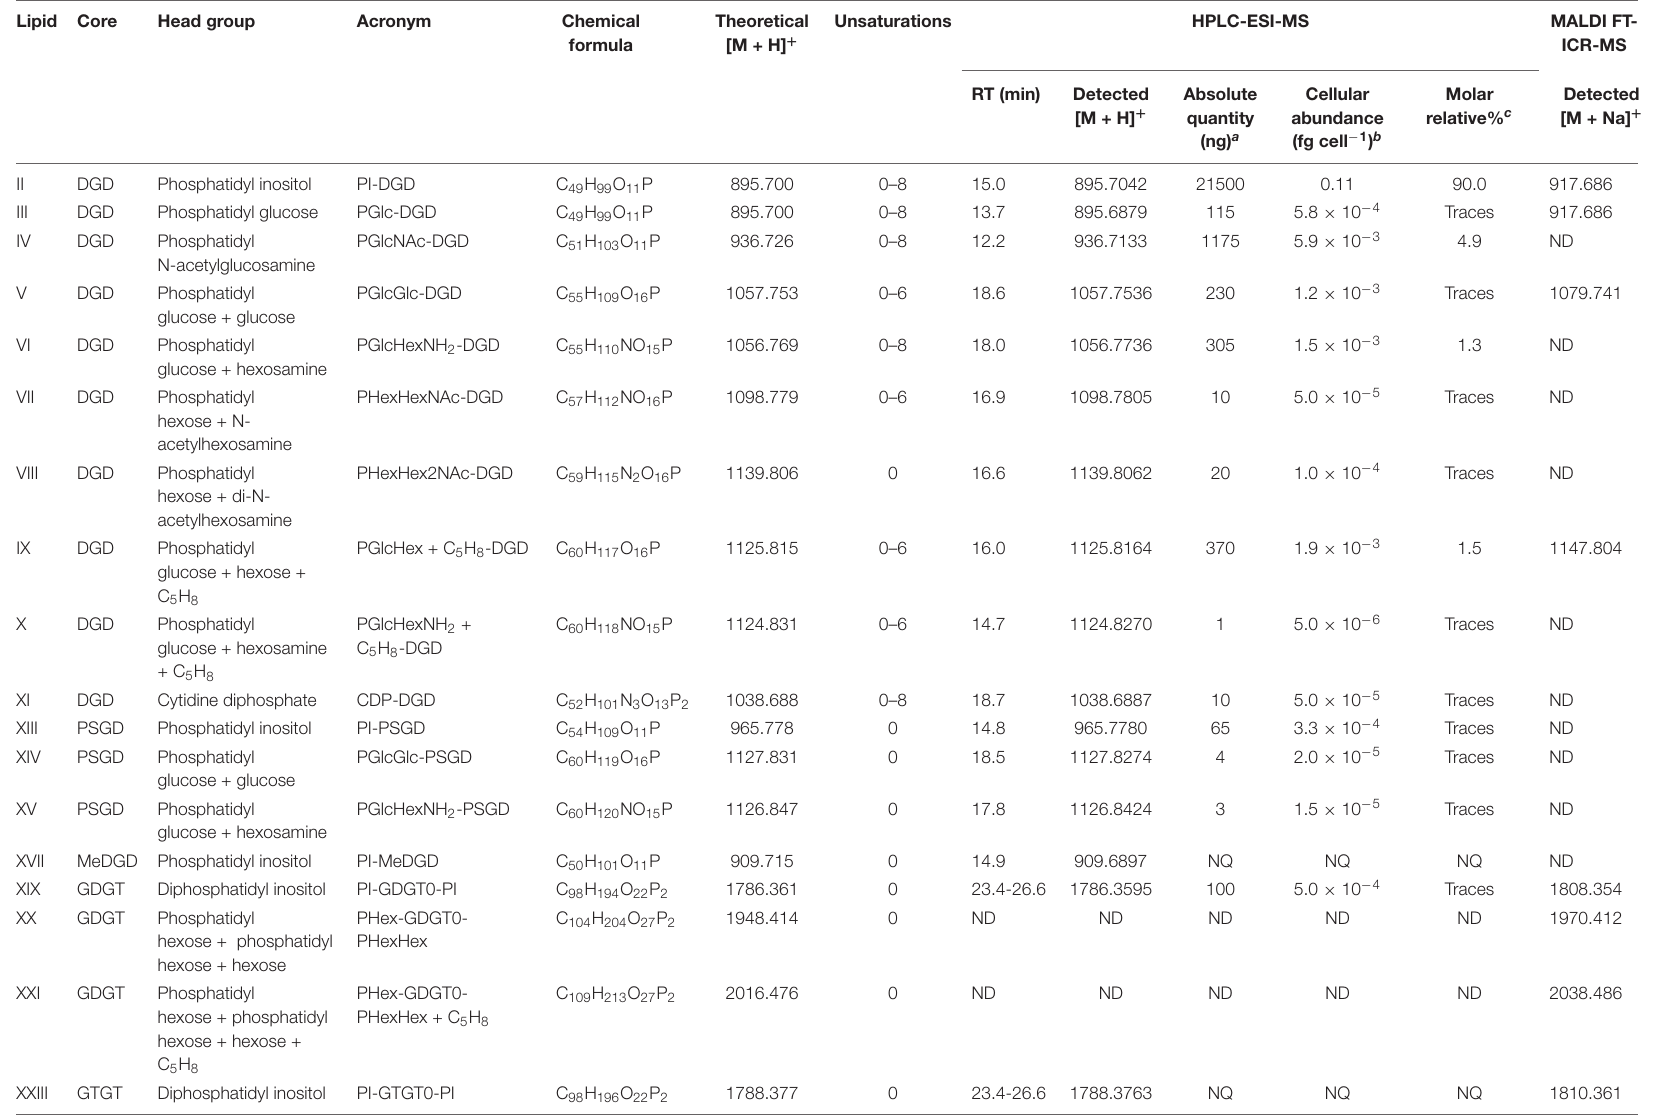
TABLE 1 | Intact polar lipid structures and lipid composition (absolute quantity, cellular abundance, and molar relative%) of Thermococcus barophilus . Lipid